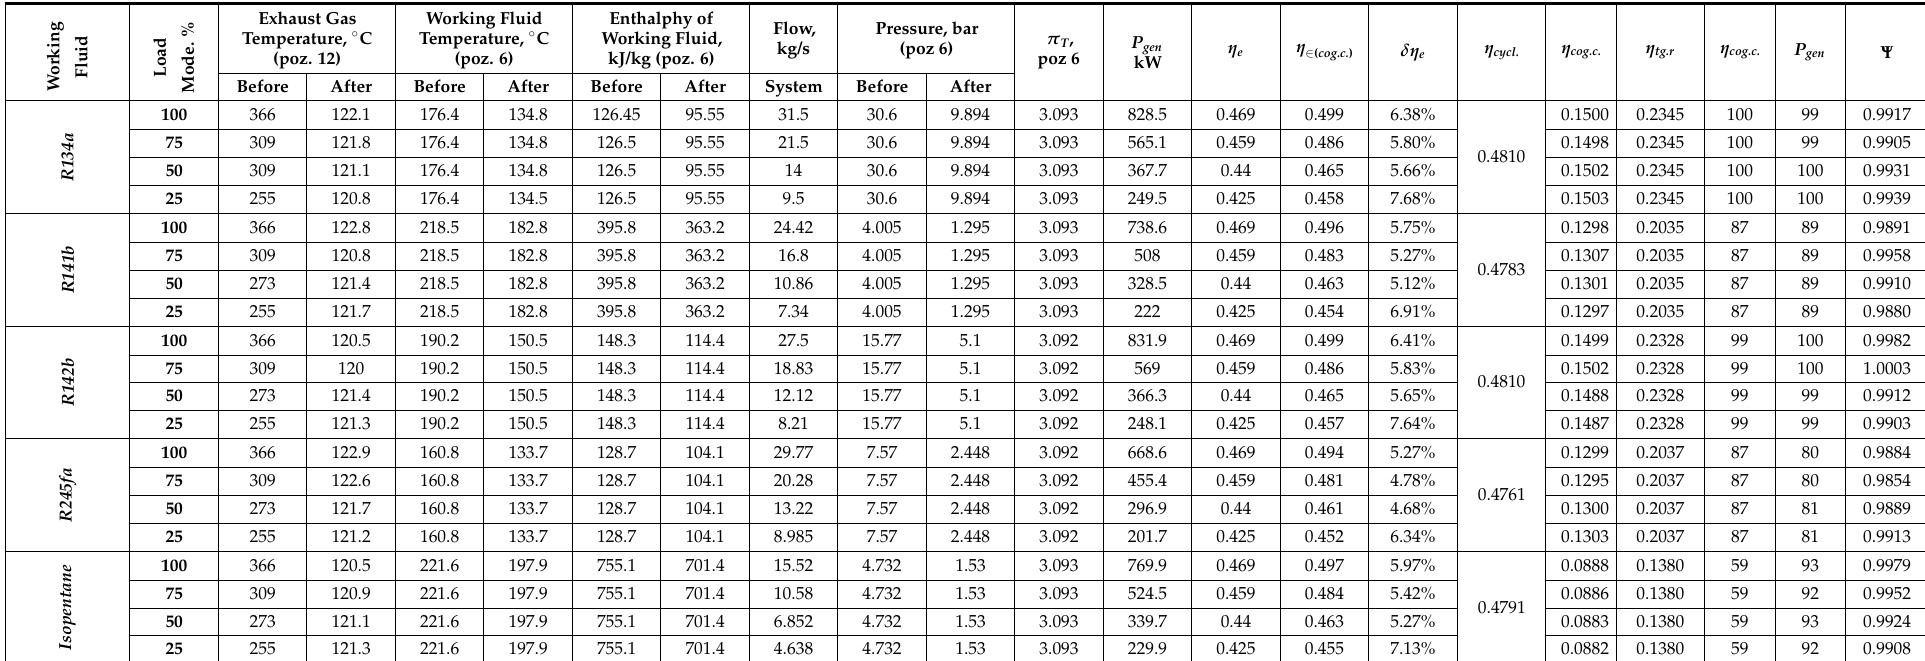
Table 5. Results of cycle simulation: strategy G w.fl. = var